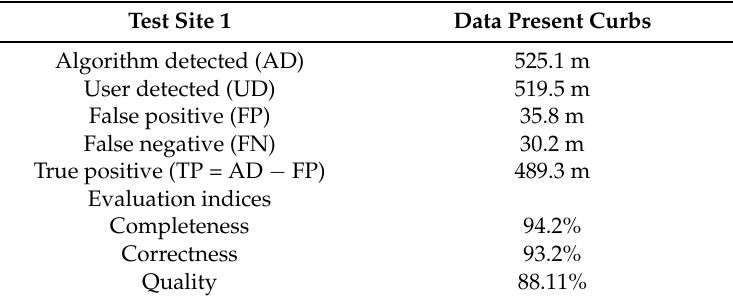
Table 2. Accuracy of the detection method at Test Site 1.